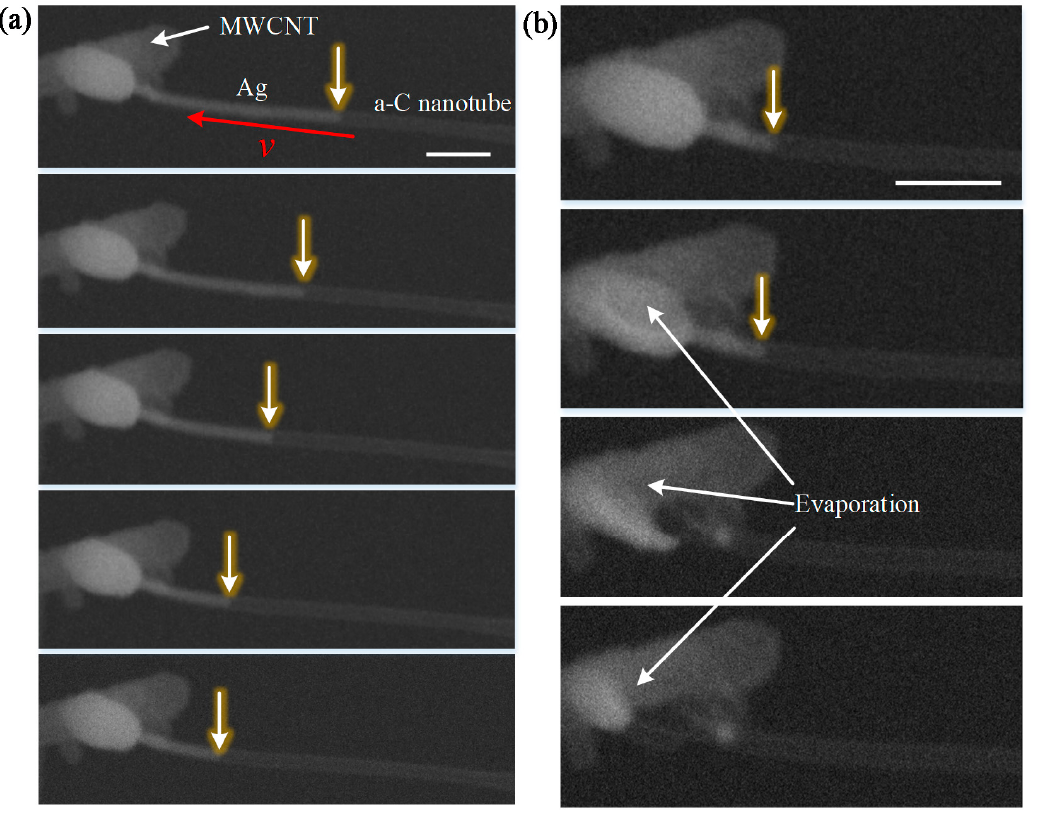
Figure 4. Reconfigurable nanointerconnection between MWCNT and Ag NW. ( a ) Nanointerconnec- tion based on the encapsulated Ag in the a-C wrapped shell; ( b ). Evaporation disconnects the nanojunction and enables new interconnections. Scale bar: 300 nm.